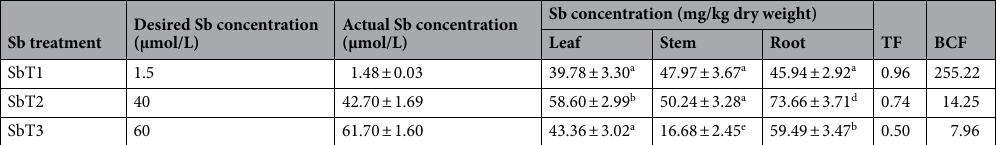
Desired Sb concentration